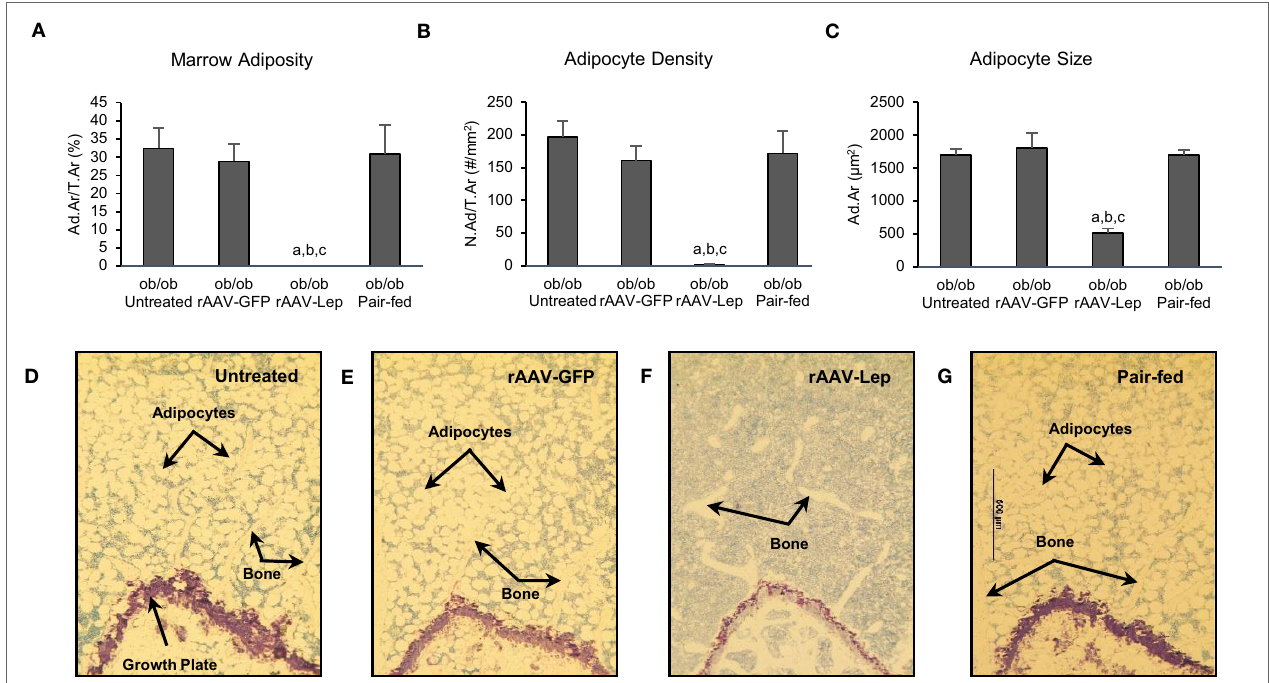
FigUre 1 | effects of hypothalamic leptin gene therapy (raaV-lep) on marrow adipose tissue in distal femur metaphysis in male ob/ob mice at 30 weeks post-vector administration . Bone marrow adiposity (a) , adipocyte density (B) , and adipocyte size (c) were decreased with rAAV-Lep treatment. The effects of treatment on marrow adipose tissue in the femoral metaphysis can be readily appreciated in representative micrographs from an untreated (D) , rAAV-GFP-treated (e) , rAAV-Lep-treated (F) , and pair-fed to rAAV-Lep (g) mouse. Please see Figures 2c–F for representative higher magnification images. Data are mean ± SE ( n = 6–8/group). a Different from untreated, b different from rAAV-GFP, and c different from pair-fed, P <